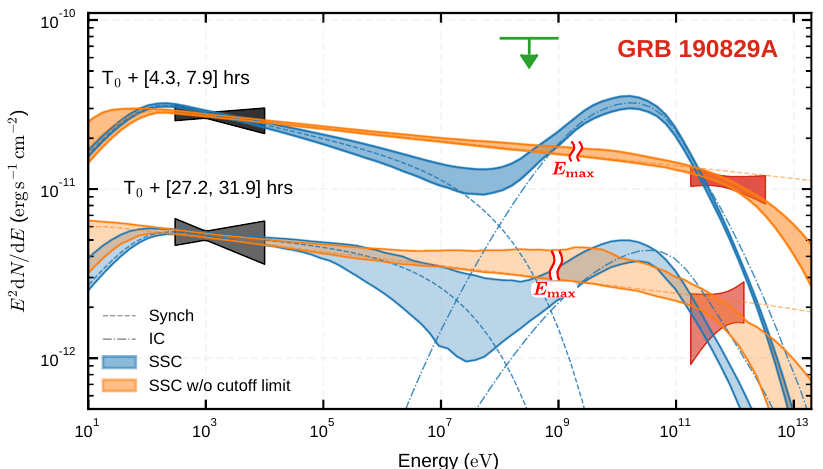
Figure 1. Synchrotron (orange) and SSC (blue) models for the emission GRB 190829A computed with naima. The shaded area represents the 68% confidence interval obtained from the MCMC fitting. Flux measurements from Swift XRT (black band), Fermi LAT (green upper limit), and H.E.S.S. (red − − band) are also displayed. Figure from [38], reproduced with permission of The American Association for the Advancement of Science.